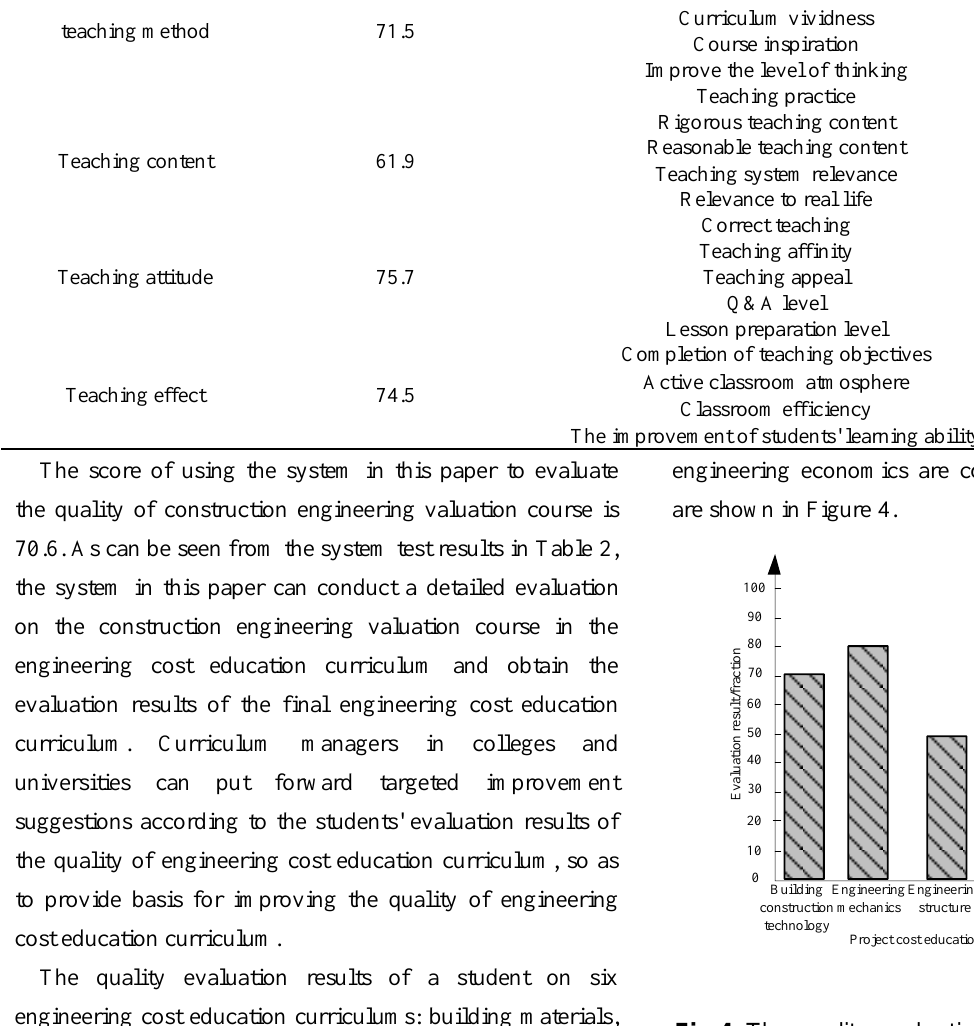
Fig 4. The quality evaluation results of six